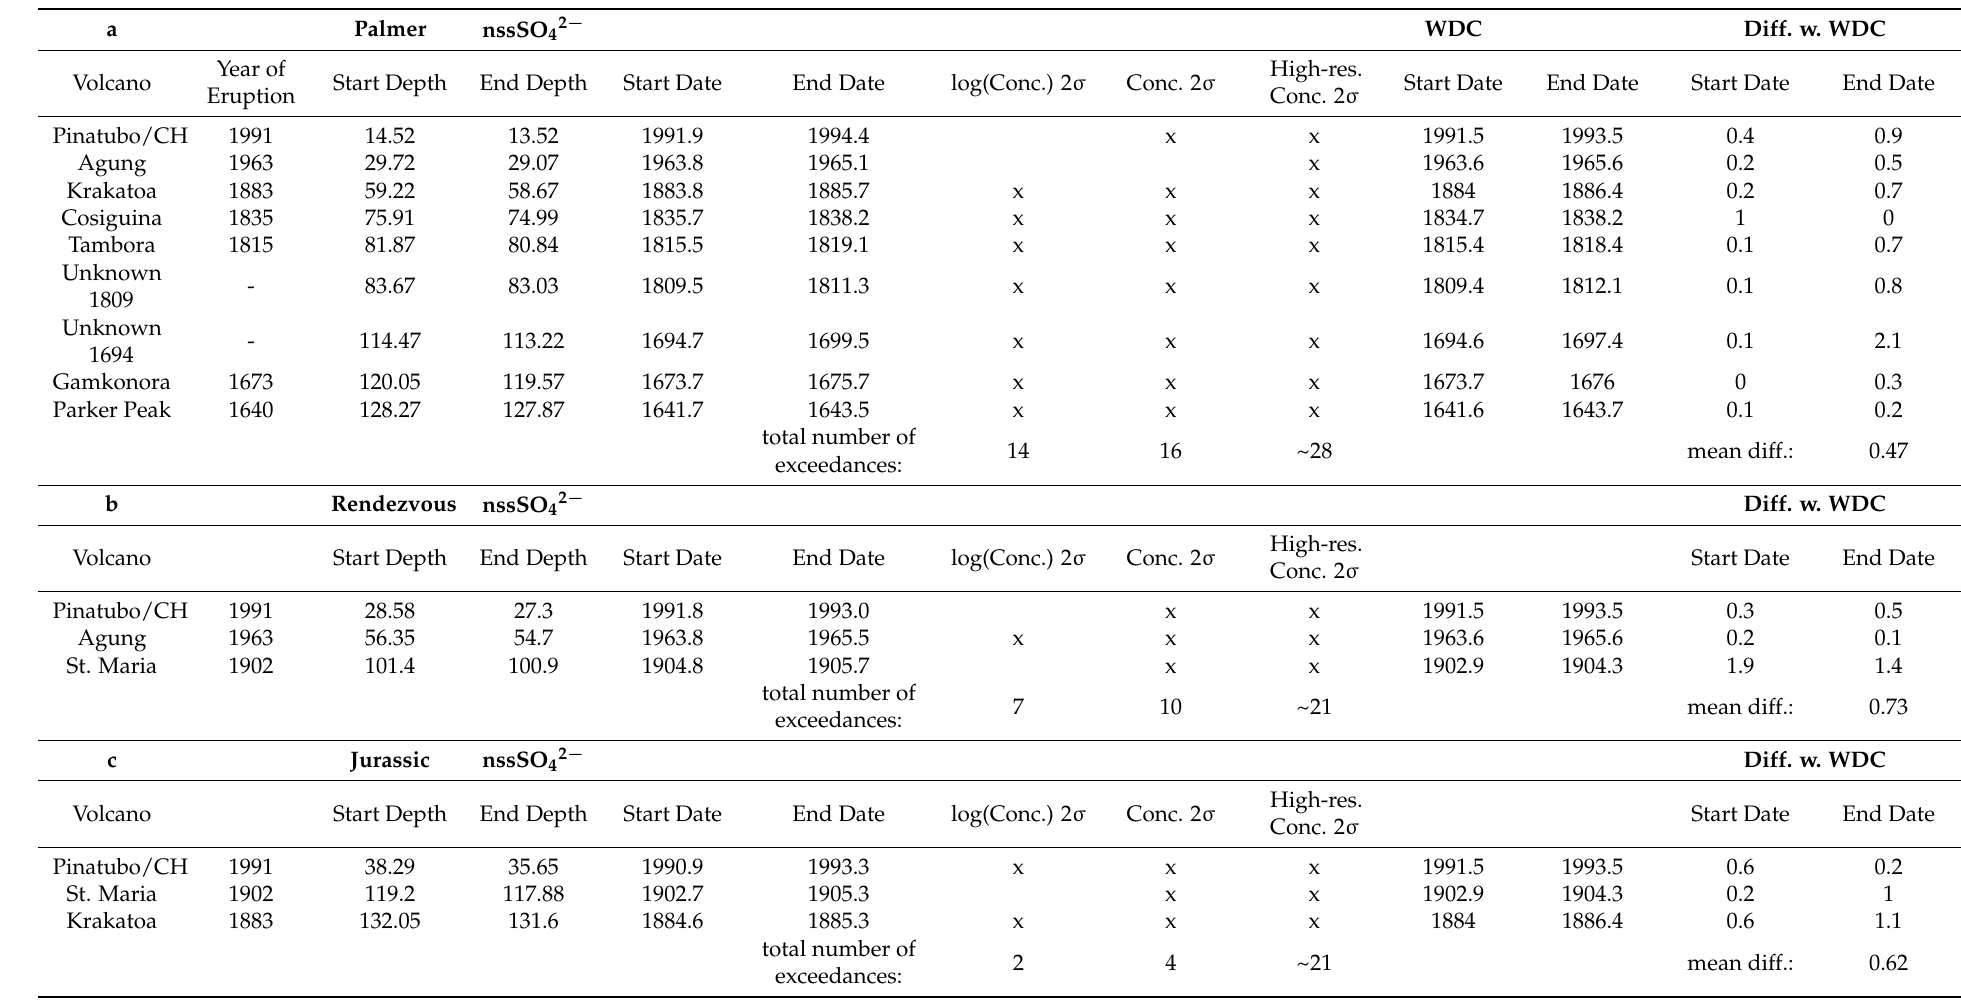
Table 2. Start and end dates of volcanic bipolar events identified in the Palmer ( a ), Rendezvous ( b ), and Jurassic ( c ) cores. The volcanic horizons (start and end dates) are compared to the event dates reported in the independently dated high-resolution WAIS Divide core (WDC06A) [32]. Diff.—difference, CH—Cerro